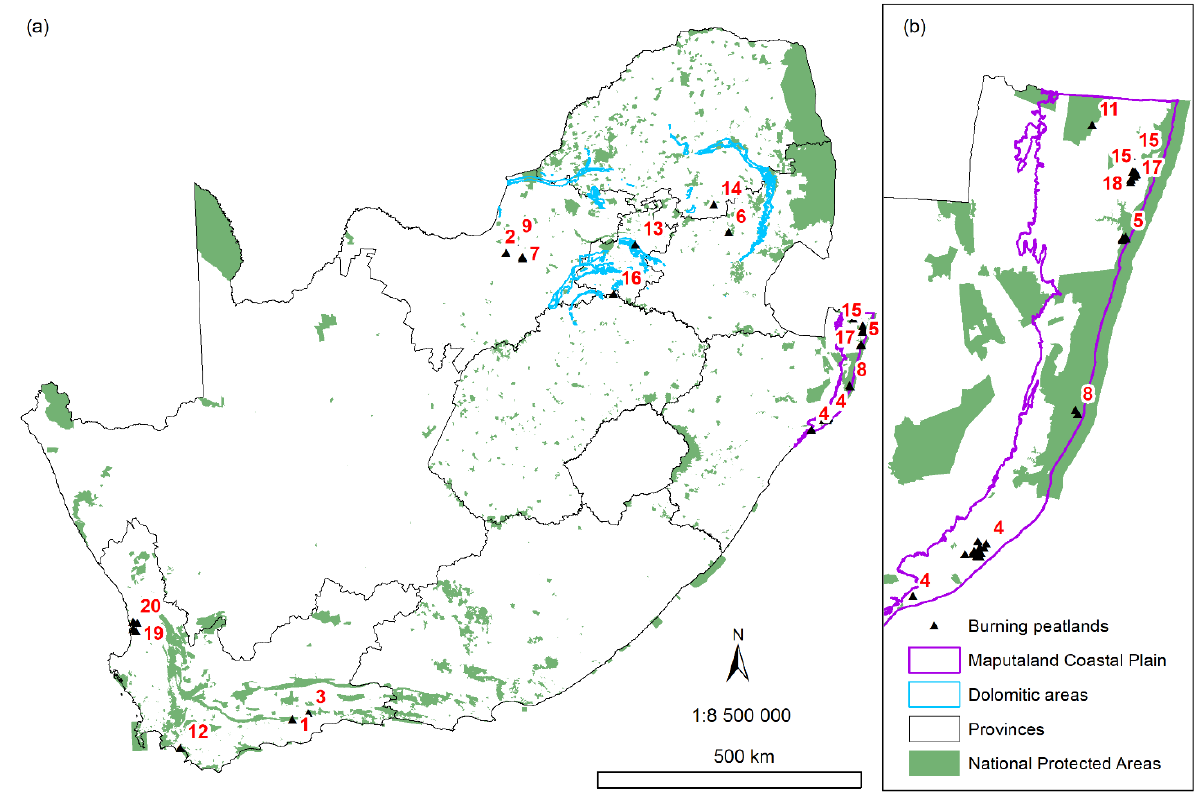
Figure 3. Location of burning peatlands across (a) South Africa and (b) the Maputaland Coastal Plain. Number labels refer to the site numbers shown in Table A2 (see